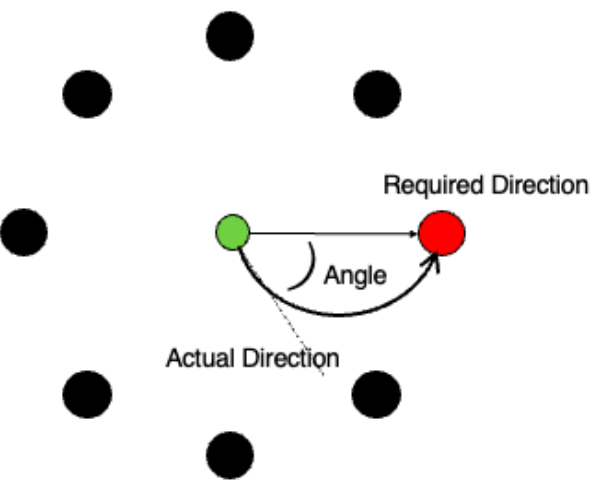
Figure 5. Schematic diagram of the rotation adaptation task (RAT).